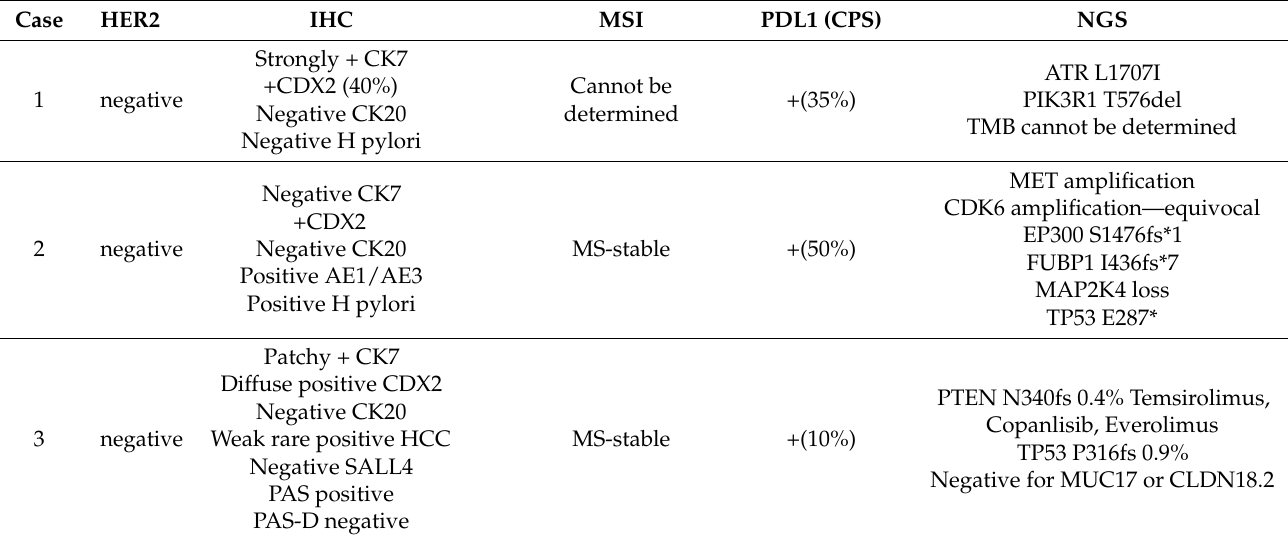
Table 2. Molecular